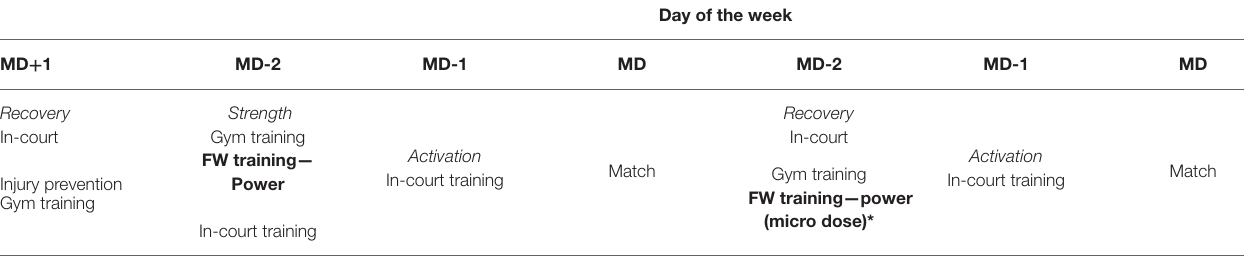
TABLE 1C | In-season weekly program for a professional basketball team (two matches per